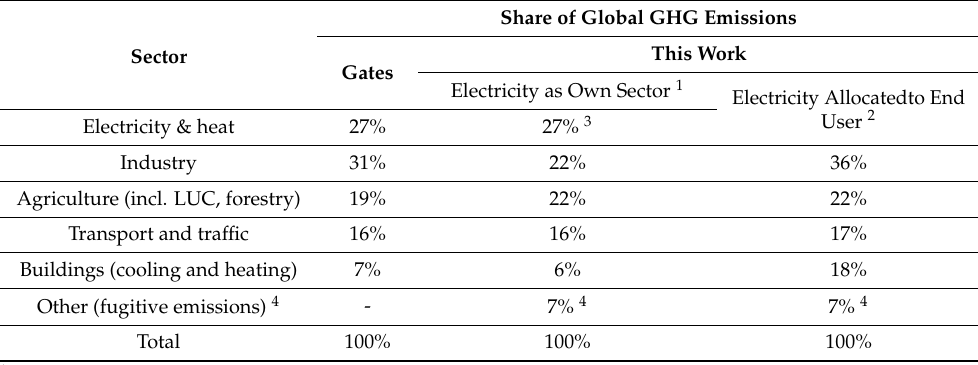
Table 2. Share of different sectors within global GHG emissions incl. land use change (LUC): comparison of data given by Gates [1] and in this